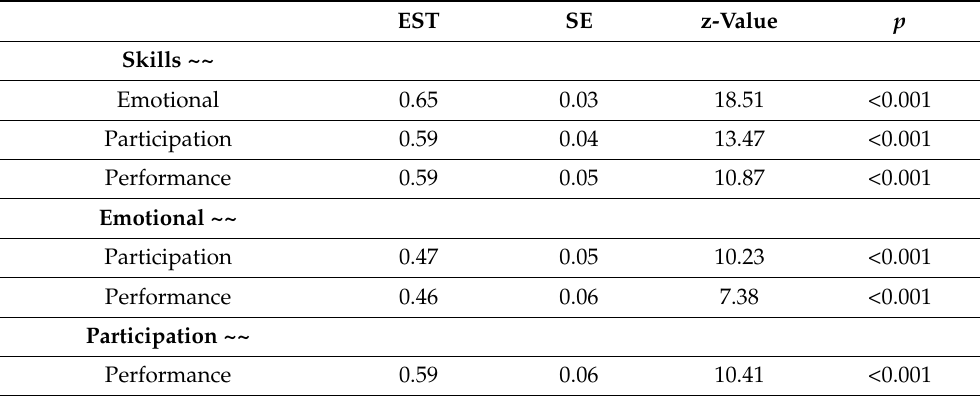
Table 4. Zero-order correlations among the latent variables (Oblimin Rotation): Estimates (EST), Standard Error (SE), z-value and significance ( p )